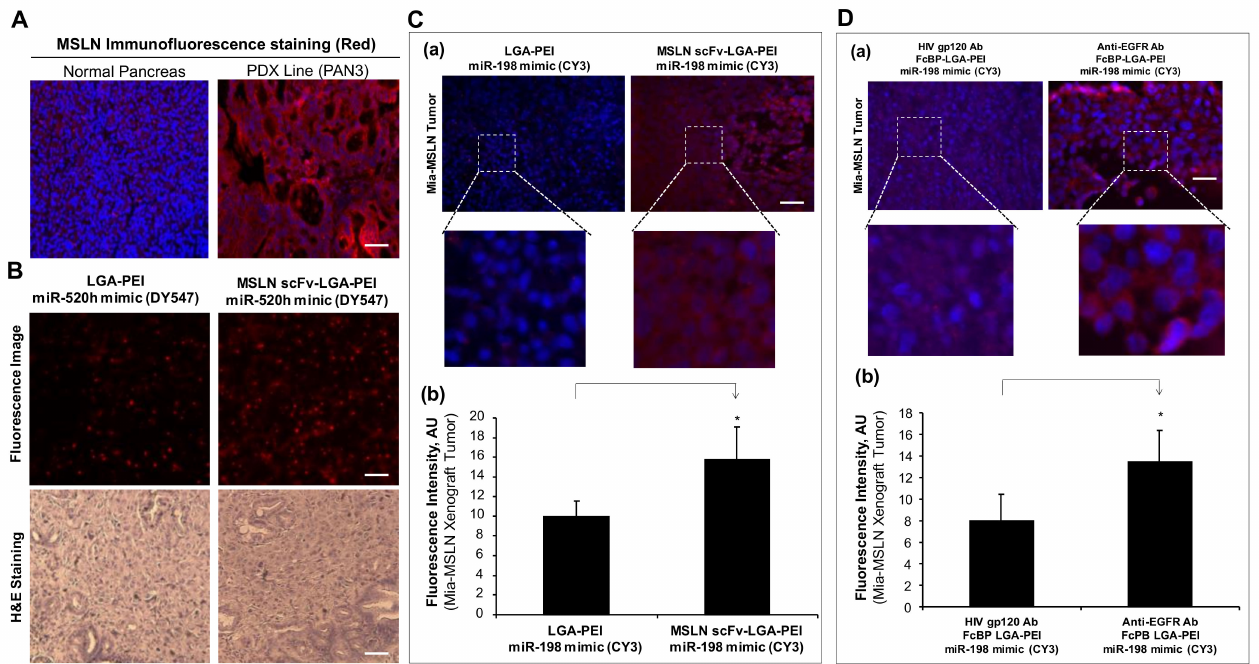
Figure 7. Targeting delivery of MSLN scFv-LGA-PEI or anti-EGFR Ab/FcBP-LGA-PEI nanoparticles (NPs) with nucleic acids to specific cancer cells in mouse models. ( A ) MSLN immunofluorescence staining (red) in normal pancreas tissue and patient-derived xenograft (PDX) pancreatic cancer tissue (PAN3). ( B ) MSLN scFv-LGA-PEI NPs delivering miR-520h mimics into pancreatic cancer tissues in a mouse model. The PDX line (PAN3) was orthotopically implanted into the pancreas of an NSG mouse (NOD scid gamma mouse) for 3 weeks. miR-520h was labeled with DY-547 and loaded into MSLN scFv-LGA-PEI or LGA-PEI polymer to form NPs. MSLN scFv–LGA-PEI (15 µ g)/miR-520h mimics (10 µ g) NPs or LGA-PEI (15 µ g)/miR-520h mimics (10 µ g) NPs were randomly injected into the mouse through the tail vein (4 mice/group). The mice were euthanized the next day, and the PAN3 tissues were harvested for immunofluorescence image and H&E staining. ( C ) MSLN scFv-LGA-PEI NPs delivering miR-198 mimics into pancreatic cancer tissues in a mouse model. Mia-MSLN cells (5 × 10 5 in 50 µ L) were orthotopically injected into the pancreas of an NSG mouse for 3 weeks when the xenograft tumor was established. miR-198 mimics were labeled with CY3 and loaded into MSLN scFv-LGA-PEI or LGA-PEI polymer to form NPs. MSLN scFv–LGA-PEI (15 µ g)/miR-198 mimics (10 µ g) NPs or LGA-PEI (15 µ g)/miR-198 mimics (10 µ g) NPs were randomly injected into the mouse through the tail vein (4 mice/group). The mice were euthanized the next day, and mouse tumors were harvested for fluorescence analysis. ( a ) Fluorescence macroscopic images. ( b ) Red fluorescence intensity from fluorescence macroscopic images. * p < 0.05. ( D ) Anti-EGFR Ab/FcBP-LGA-PEI NPs delivering miR-198 mimics into pancreatic cancer tissues in a mouse model. Mia-MSLN cells (5 × 10 5 , 50 µ L) were orthotopically injected into the pancreas of an NSG mouse for 3 weeks. NPs were prepared with 10 µ g Cy3-labelled miR-198 mimics 15 µ g LGA-PEI and 4 µ g FcBP-LGA-PEI polymer with anti-EGFR Ab or HIV gp120 Ab. Anti-EGFR Ab/FcBP-LGA-PEI/miR-198 mimics NPs or HIV gp120 Ab/FcBP-LGA-PEI/miR-198 mimics NPs (200 µ L) were randomly injected into the tumor-bearing mice through the tail vein (4 mice/group). The mice were euthanized the next day, and the Mia-MSLN tumor tissues were harvested for fluorescence image ( a ) and fluorescence intensity analysis ( b ). * p < 0.05. Scale bar (50 µ